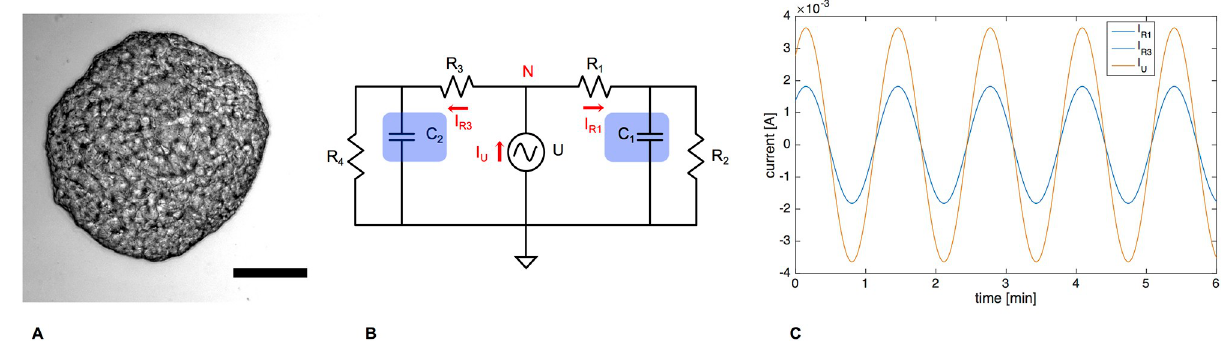
Fig 16. Case 1: Stationary, unpolarized microplasmodium. A) Stationary, unpolarized microplasmodium. Scale bar = 100 μ m. B) Symmetrical model circuit for an oscillating but stationary microplasmodium. C = capacitors, R = resistors, U = voltage source, I = current, N = node. C) Current flowing through the right side as taken at R 1 and R 3 (blue) and the voltage source ( I U ,